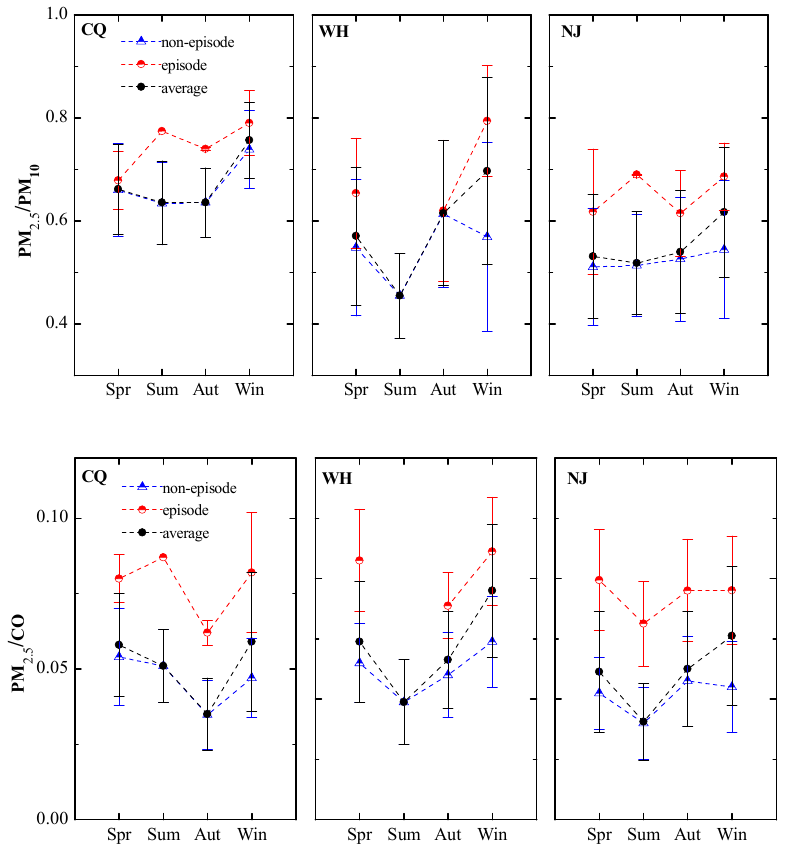
Figure 7. Seasonal ratios of PM 2.5 /PM 10 ( up ) and PM 2.5 /CO ( down ) in the three cities.